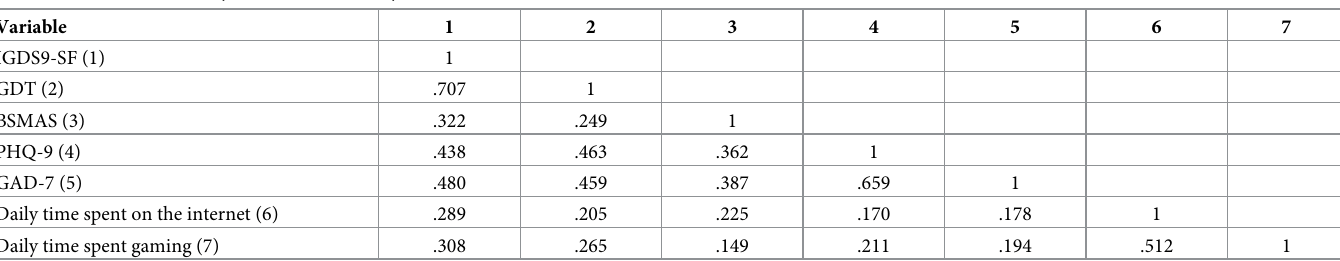
Table 4. Correlational analysis of the main study variables.